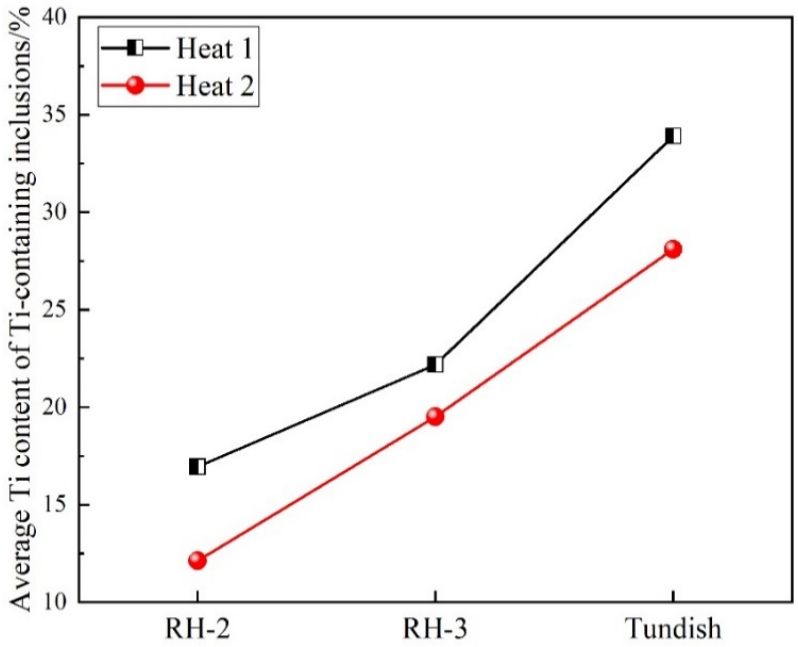
Figure 4. Transformation of inclusion composition during RH refining and tundish processes. The unstable oxides in slag or refractory materials, including FeO, MnO, SiO 2 and other oxides; a source of oxygen in the added Ti-Fe alloy or sponge titanium; and the air inhalation into molten steel under the poor protection effect may all cause the reoxidation of molten steel, resulting in the increased content of the dissolved oxygen and total oxygen and a large loss of alloying elements in molten steel [14,19–21]. As can be seen from the change of N content in Table 1, the increase in N content in molten steel from RH-end to tundish is below 4 ppm. During the whole producing process, the N contents in molten steel do not obviously increase and are all below 20 ppm. Consequently, the reoxidation caused by the absorbed air is basically